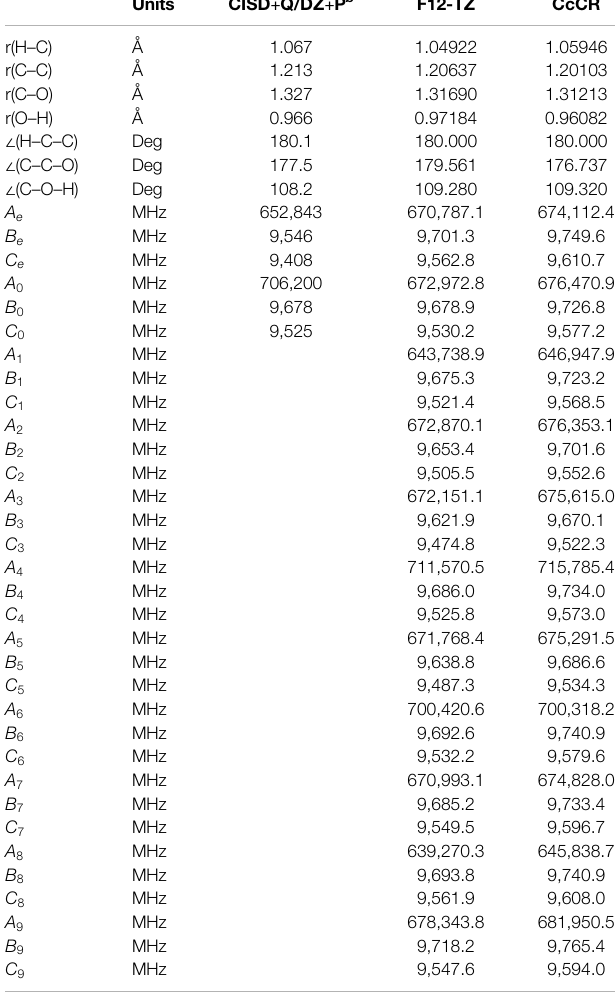
TABLE 1 | Structural data and rotational constants for HCCOH.